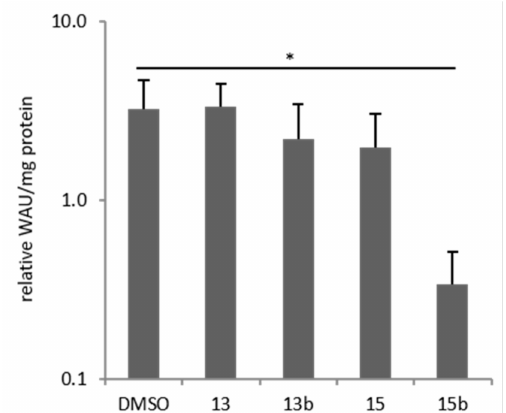
Figure 8. Hypoxia-induced CA activity. Extracellular pH measurements were used to determine CA activity. HS578T cells were cultured under normoxia (21% O 2 ) or hypoxia (0.1% O 2 ) for 24 h and subsequently treated with betulin derivatives for 3 h. The pH e value of normoxic cells was set as 1.0 WAU/mg protein and the diagram shows the relative WAU/mg protein of the treated cells. Data represent mean values (+SD) of at least five independent experiments. Significant p values are highlighted with an asterisk (* p ≤